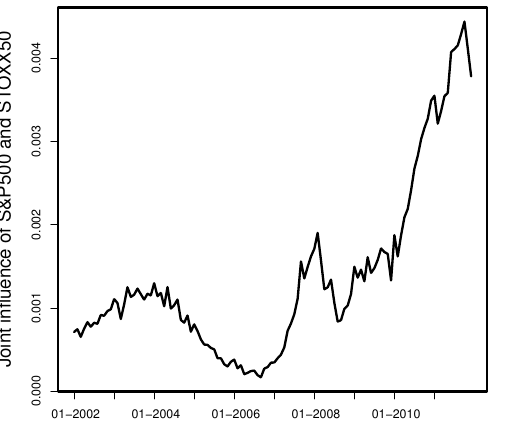
Figure 17. Sensitivity of the logarithmized ARR on a joint movement of S&P500 and STOXX50.